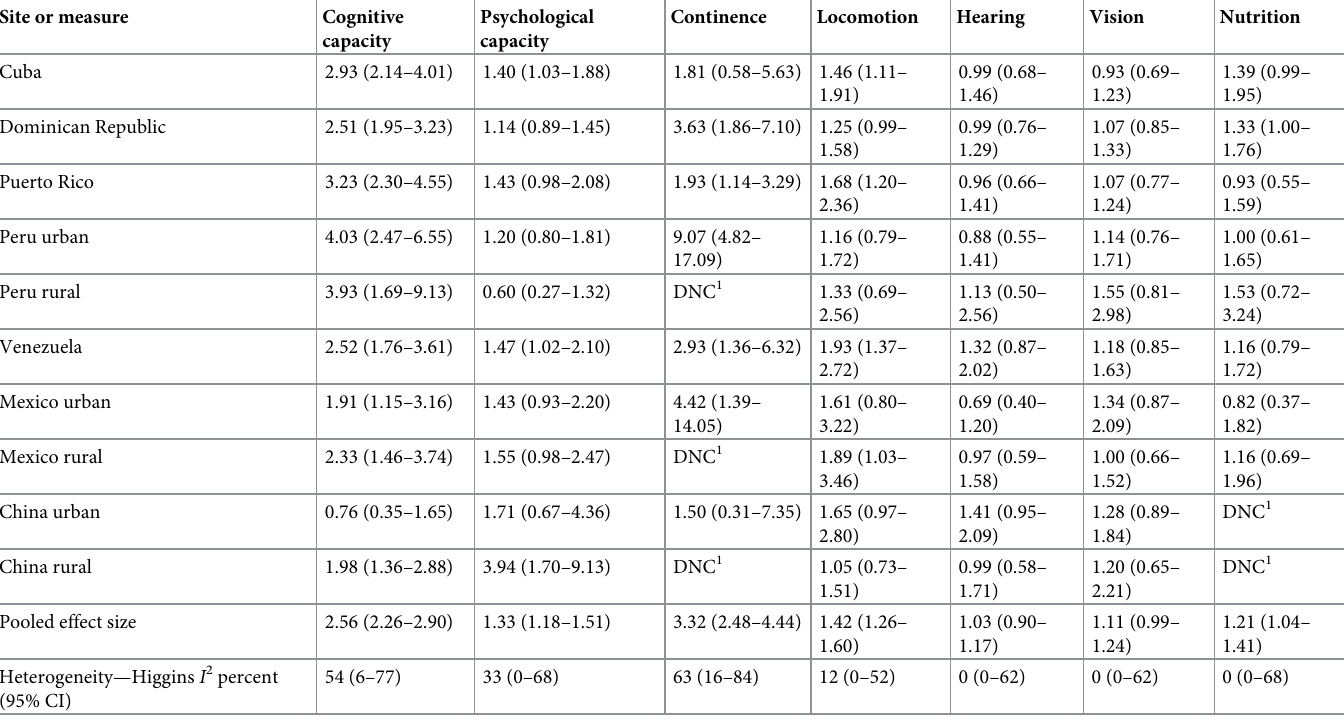
Table 4. Adjusted associations of individual declines in intrinsic capacity with incident dependence.